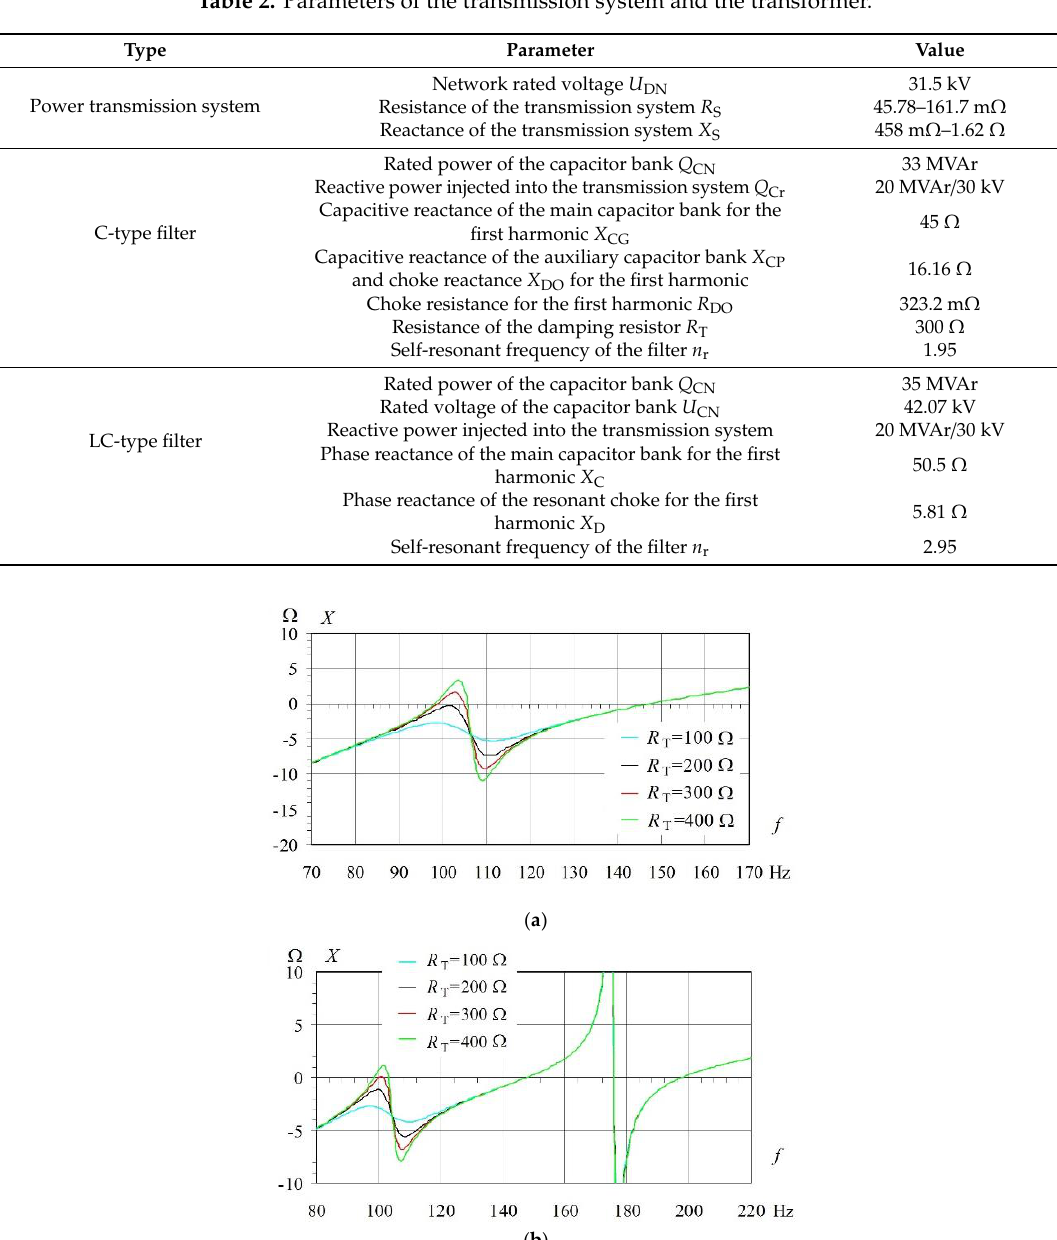
Table 2. Parameters of the transmission system and the transformer.